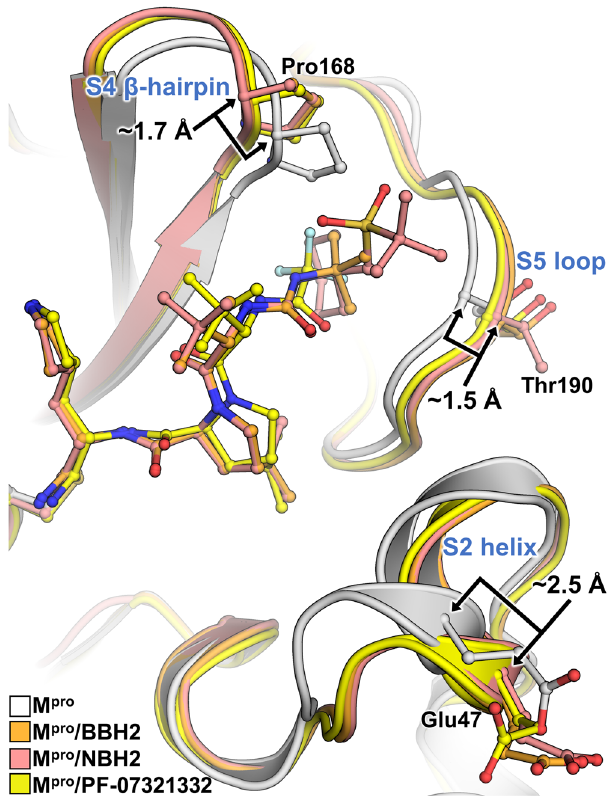
Fig. 5 Active site structural plasticity of M pro bound to nitrile warhead inhibitors. Comparison of ligand-free M pro (7JUN, white cartoon) with the BBH-2, NBH-2, and PF-037321332 complexes shows signi fi cant structural shifts in protein subsites S2, S4, and S5 responsible for binding to inhibitor P2, P4, and P5 moieties respectively. Distances are given in angstroms (Å). Superposition is calculated by the least-square- fi tting of C α